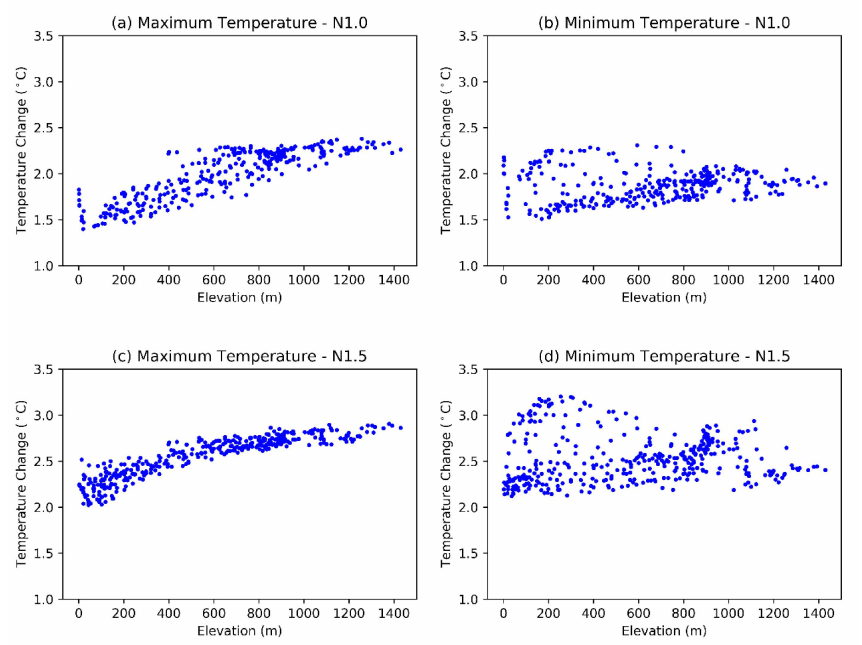
Figure 5. Scatter plot of future changes in maximum and minimum temperatures for 2060–2079 relative to 1990–2009 vs. elevation. Here each dot represents multi-model mean future change in maximum and minimum temperature for N1.0/N1.5 respectively for a NARCliM grid cell over the Alpine